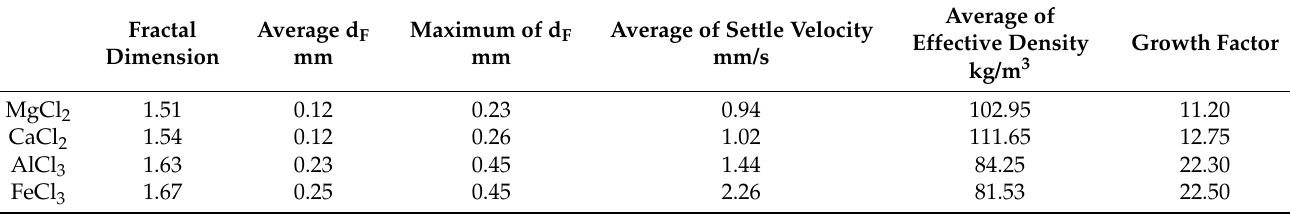
Figure 7. Floc image at the end of coagulation process for different coagulants under various dosages. The coagulants were MgCl 2 , CaCl 2 , AlCl 3 , and FeCl 3 from top to bottom, respectively. The dosage of MgCl 2 , CaCl 2 , AlCl 3 and FeCl 3 were 0.6 mM, 0.6 mM, 0.05 mM, and 0.06 mM, respectively. The characteristics of different coagulants are summarized in Table 4. Table 4. Summarization of floc characteristics by different